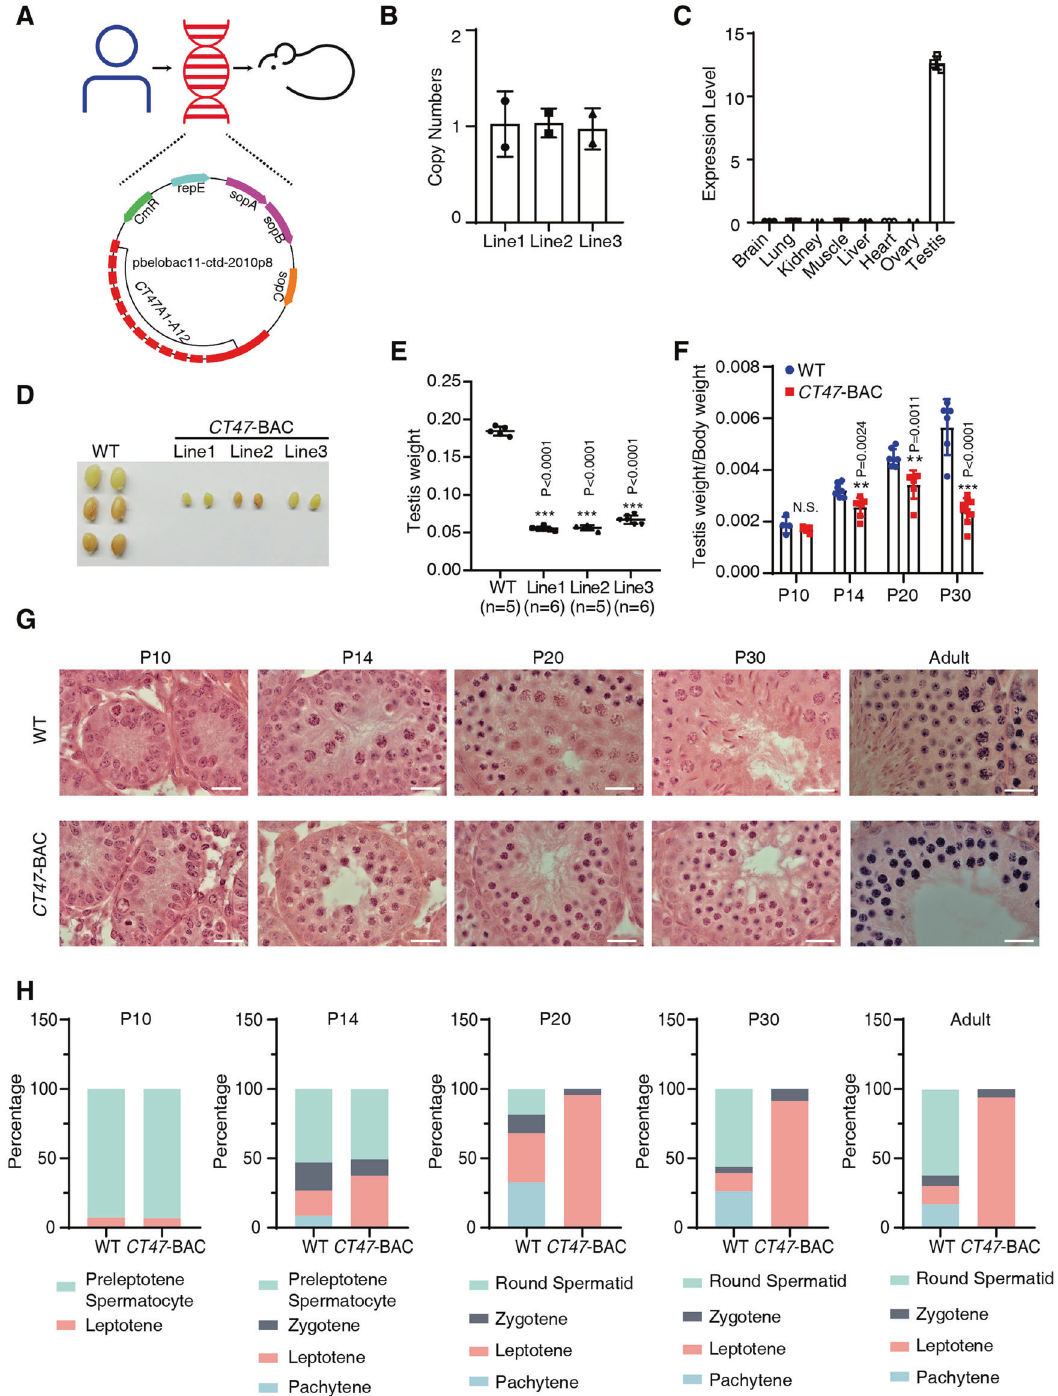
Fig. 2 Meiotic maturation arrest in humanized CT47 -BAC testes. A Generation of CT47 -BAC transgenic mice. The 212 kb BAC clone ctd2010- p8 (containing human CT47.1 to CT47.12) was microinjected into mouse pronuclei. B Estimated CT47 transgene copy number in the three transgenic mouse lines estimated from qPCR data. Three independent experiments were conducted. C CT47 expression level in 8 different tissues of CT47 -BAC mice. The mean values ± standard deviation (SD) are shown. D Testis morphology of 2-month-old wild-type and three lines of CT47 -BAC mice. E Testis weight of 2-month-old wild-type and three lines of CT47 -BAC mice. The mean value ± SD is shown. Signi fi cance is shown by Student ’ s t test: WT ( n = 5); Line 1 ( n = 6); Line 2 ( n = 5); Line 3 ( n = 6), *** p < 0.001. F Relative testis weight (testis weight per g body weight) of WT mice (blue dot) and CT47 -BAC mice (red dot) at postnatal Days 10, 14, 20, and 30. The mean values ± SD are shown. Signi fi cance is shown by Student ’ s t test, P10 WT ( n = 4), CT47 -BAC ( n = 4); P14 WT ( n = 7), CT47 -BAC ( n = 7); P20 WT ( n = 7), CT47 -BAC ( n = 7); P30 WT ( n = 6), CT47 -BAC ( n = 6) * p < 0.05, ** p < 0.01. G Hematoxylin and eosin staining of wild-type and CT47 -BAC testes at P10, P14, P20, P30, and adulthood (8 weeks). Scale bar = 20 μ m. H Spermatocyte types were identi fi ed based on nuclear morphology and their positions within tubules. The proportion of spermatocyte types was analyzed in WT and CT47 -BAC mice at P10, P14, P20, P30, and adulthood (8 weeks).